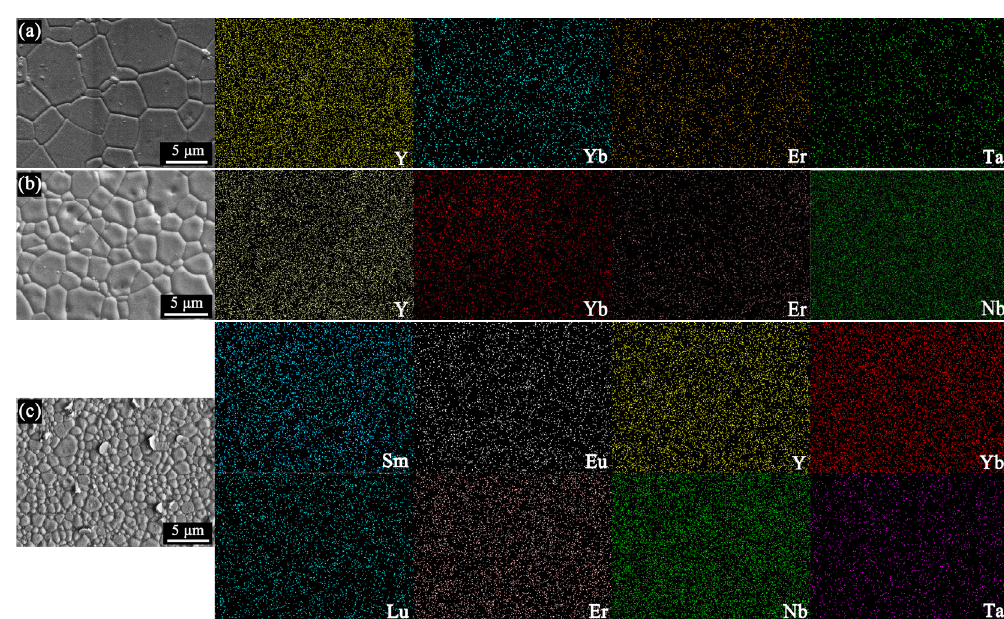
Fig. 3 SEM images and the corresponding EDS mappings of the containing multi-principal metal elements of the bulk HE RE 3 TaO 7 , RE 3 NbO 7 , and RE 3 (Nb 1/2 Ta 1/2 )O 7 compacts after thermal etching at 1400 ℃ for 2 h : (a) (Y 1/3 Yb 1/3 Er 1/3 ) 3 TaO 7 , (b) (Y 1/3 Yb 1/3 Er 1/3 ) 3 NbO 7 , and (c) (Sm 1/6 Eu 1/6 Y 1/6 Yb 1/6 Lu 1/6 Er 1/6 ) 3 (Nb 1/2 Ta 1/2 )O 7 .